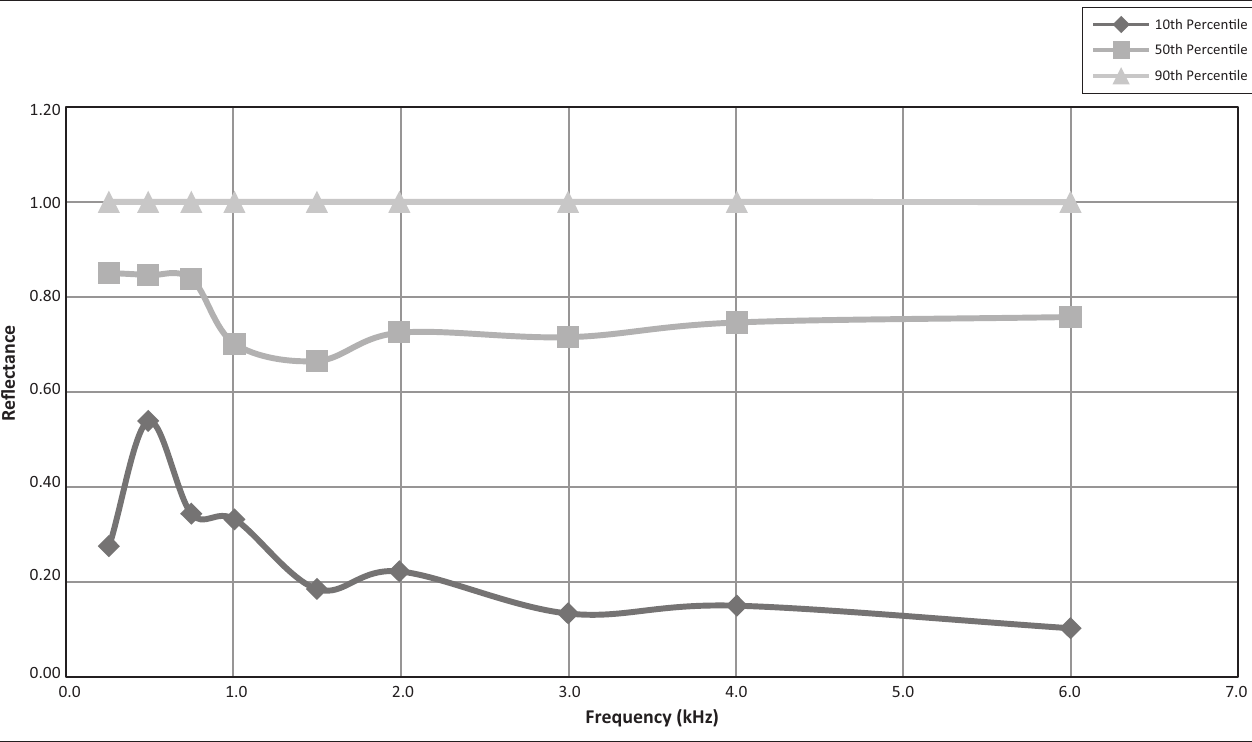
FIGURE 1: Reflectance data for tone stimuli at individual frequencies ( n = 82